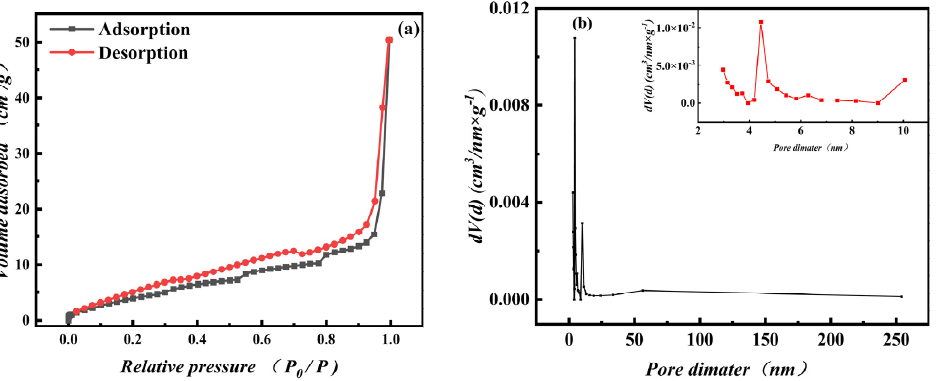
Figure 5. N 2 adsorption isotherm ( a ) and pore size distribution ( b ) of Fe 3 O 4 − MOS.